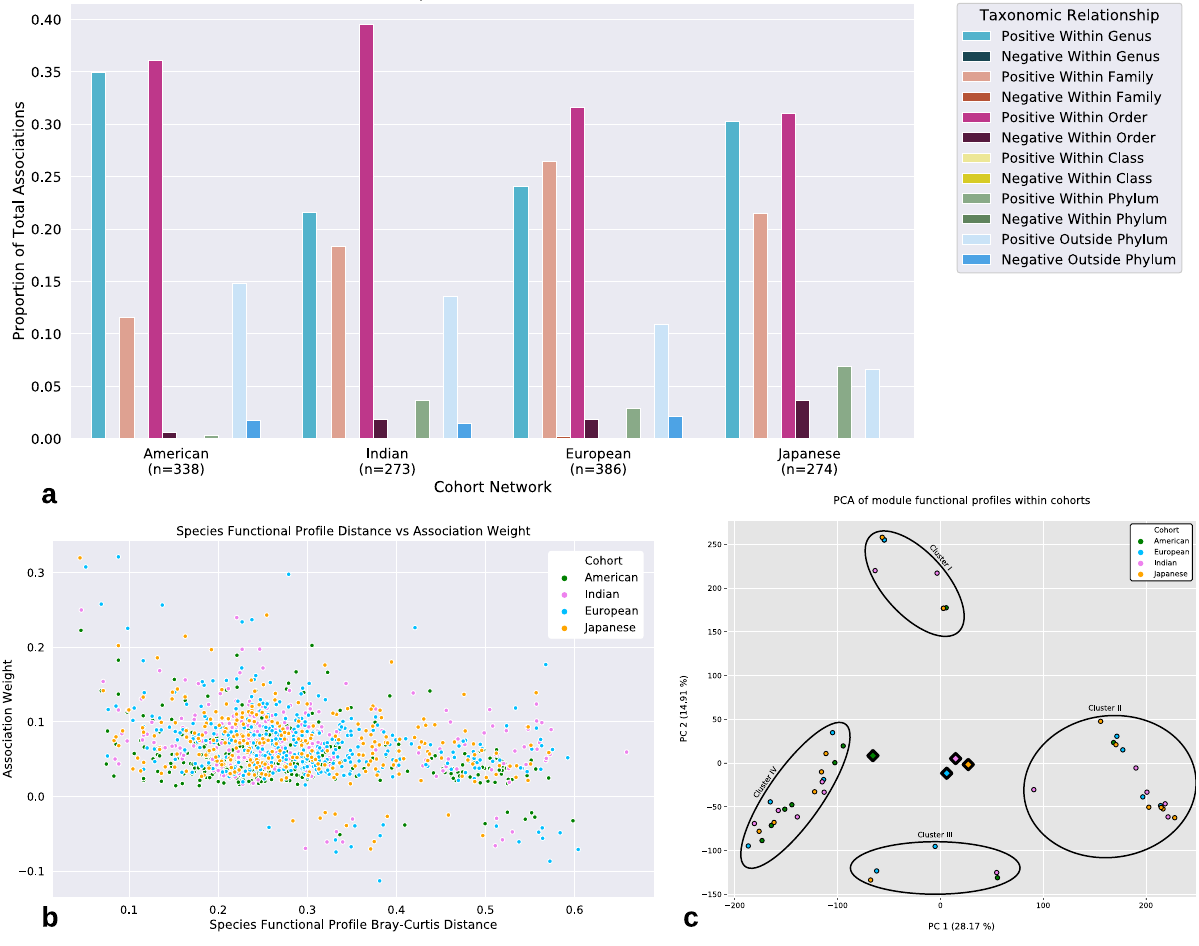
Figure 4. Taxonomic and functional relationships between species. ( a ) Proportion of associations within each cohort’s network that are either positive or negative at the lowest level of taxonomic relation (n = total associations). Most positive associations appear between taxonomically similar species. ( b ) Association weight vs Bray–Curtis distance of genome functional profiles between network partners. Positive associations between functionally similar species are both common and greater in strength than negative associations. There appears to be a minimal distance between genome functional profiles before a negative association is demonstrated. ( c ) An asynchronous LPA was used to analyze the modules composing the networks of each cohort. Each dot represents the aggregated TIGRFAM profiles of an individual module found by aLPA and the diamonds represent the cohort centroids. Four distinct clusters were found, and each cohort was represented within each cluster. The American cohort appears to be biased towards Cluster IV, however the other cohorts do not appear overtly biased to any one